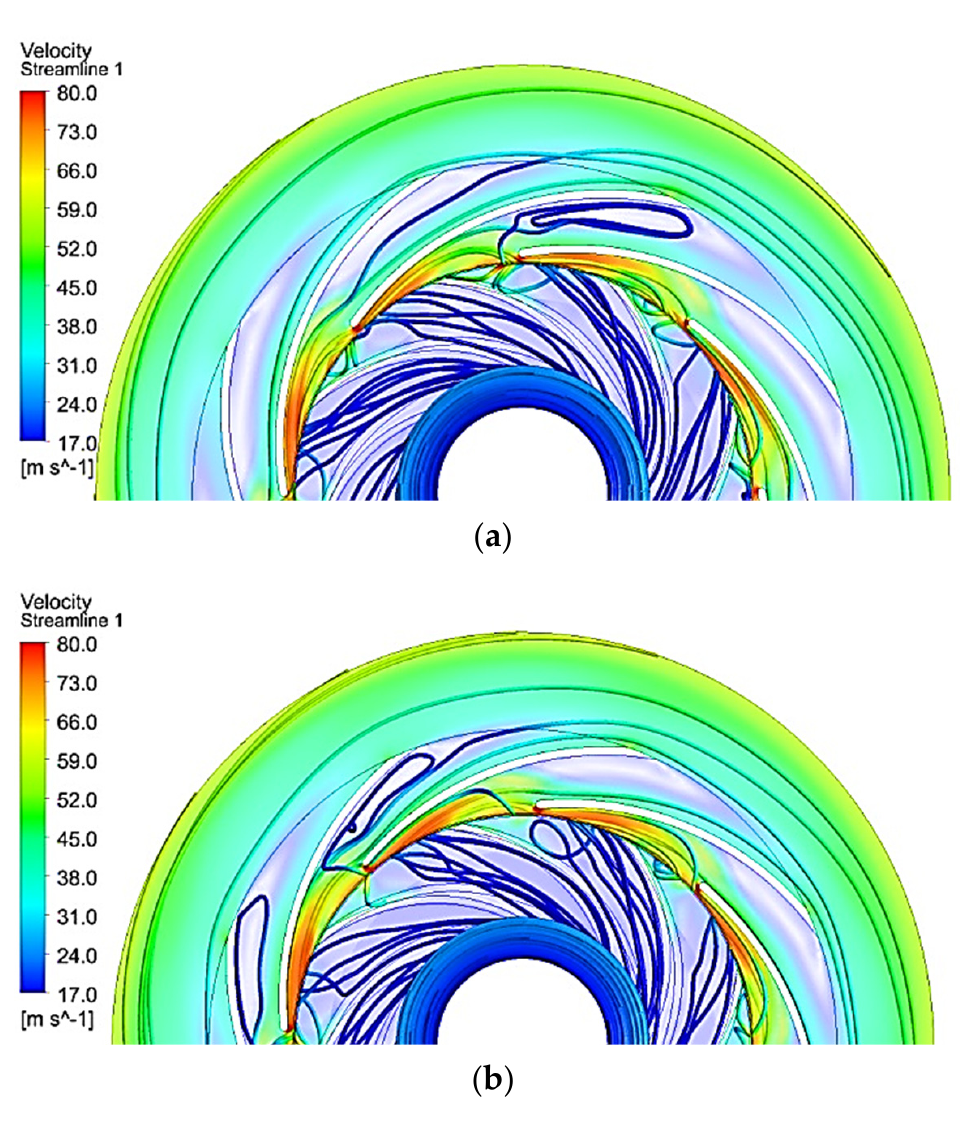
Figure 5. Stages with trimming of 10 mm: ( a ) D 4 = constant; ( b ) h = constant. The last step was the calculation of counter-rotating stages with various trimmings of 20 mm (Figure 7). The characteristics of these degrees were as follows: the first option ( D 4 = constant)— H = 348 m, N = 282 kW, and η = 60%; the second option ( h = constant)— H = 276 m, N = 241 kW, and η =